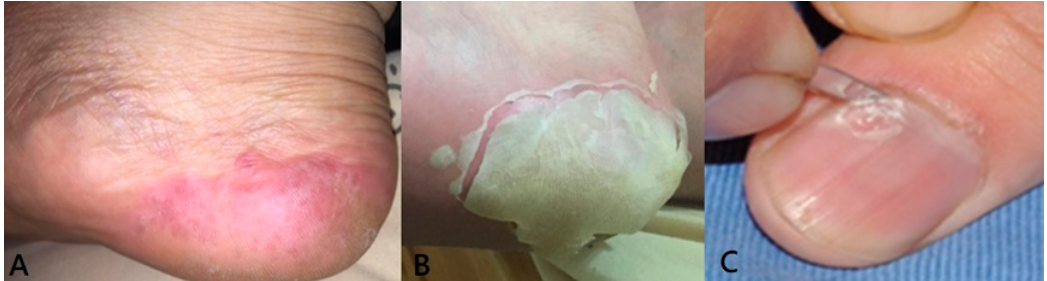
Figure 1. ( A ) In the acute stage, the cutaneous lesions, such as erythematous papules and pustules, around the nail matrix of the first, fourth and fifth toenails of left foot are relatively prominent than on the second and third toe; ( B ) about two months later, onychomadesis on the second and third toe of left foot.